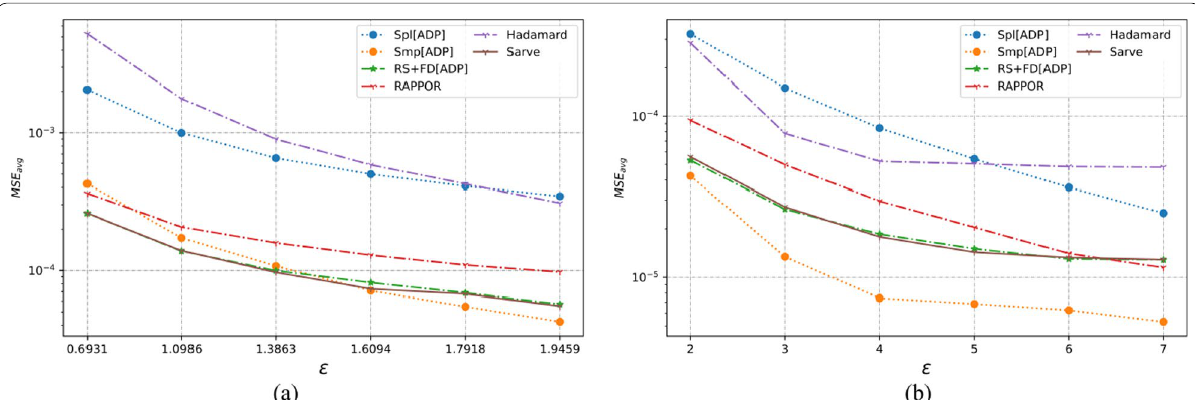
Fig. 7 The MSE averaged over 100 runs for the MS-FIMU dataset privatized using different randomization techniques and fake data under a high privacy regime, experimental setup labeled ES_Real_3 in Table 1; b general privacy regime, experimental setup labeled ES_Real_6 in Table 1